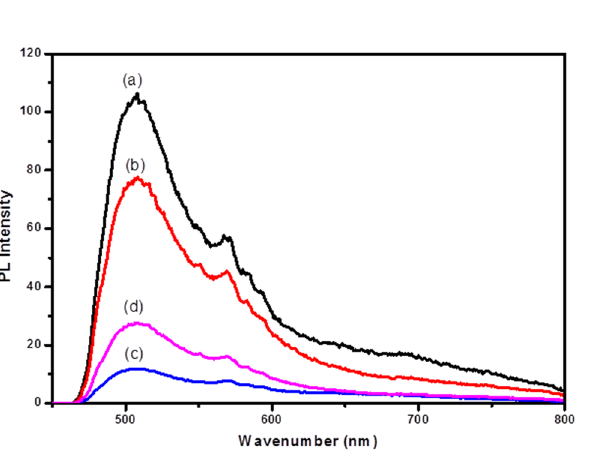
Figure 5. UV–Vis absorbance spectra of ( a ) Fe 3 O 4 –FeVO 4 and xRGO/Fe 3 O 4 –FeVO 4 at ( b ) 5%, ( c ) 10%, ( d ) 15% wt.% of RGO.